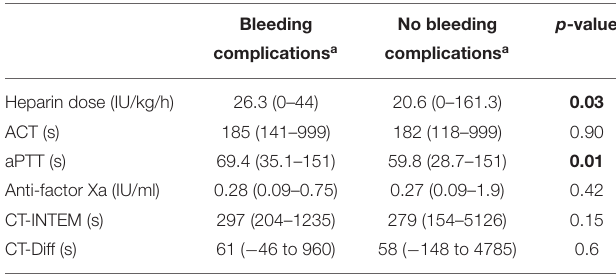
TABLE 4 | Comparison of the median values from heparin dose and coagulation assays in the group of patients with and without bleeding complications. Bleeding No bleeding p -value